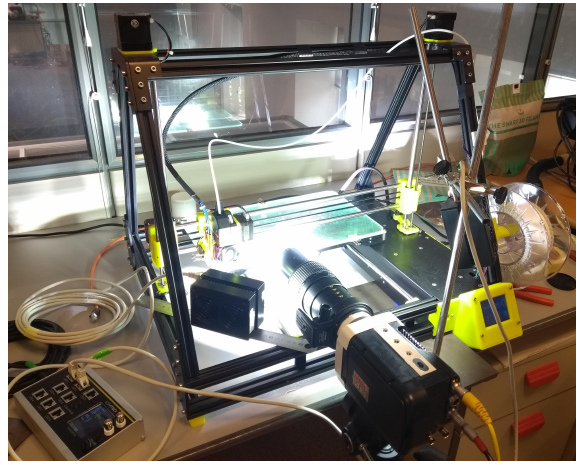
Figure 2. Experimental setup with high-speed camera and illumination.